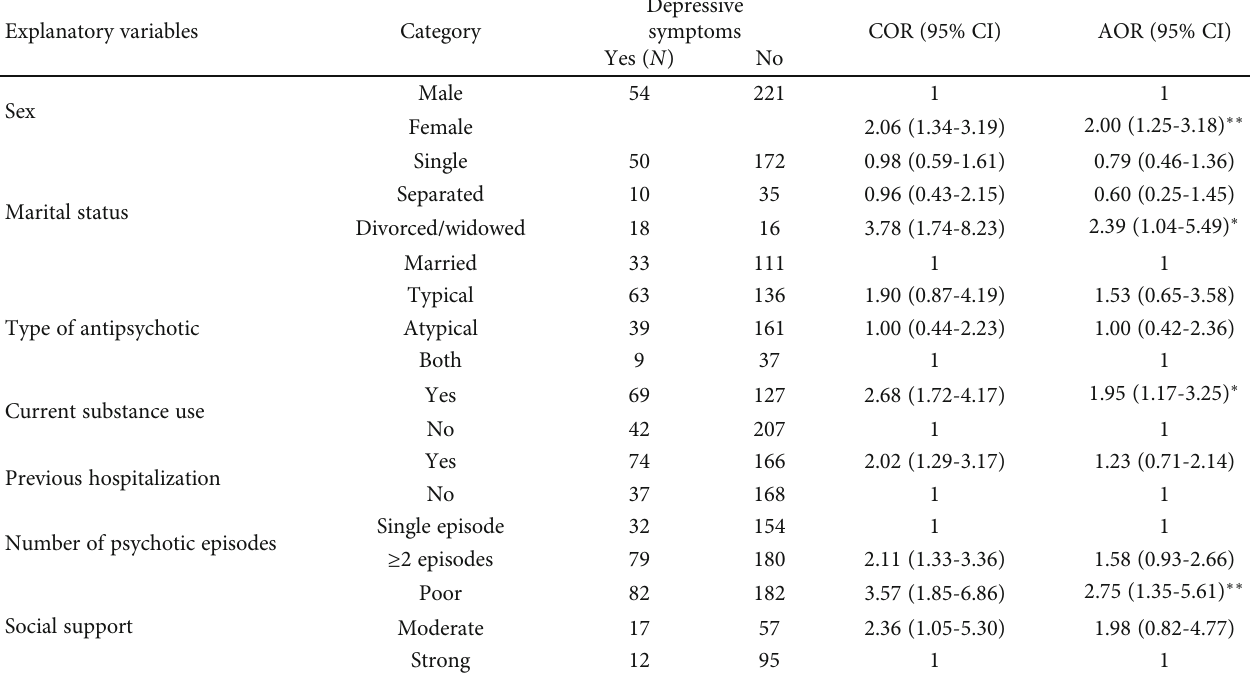
Table 3: Factors associated with depression among the patients with schizophrenia in multivariable logistic